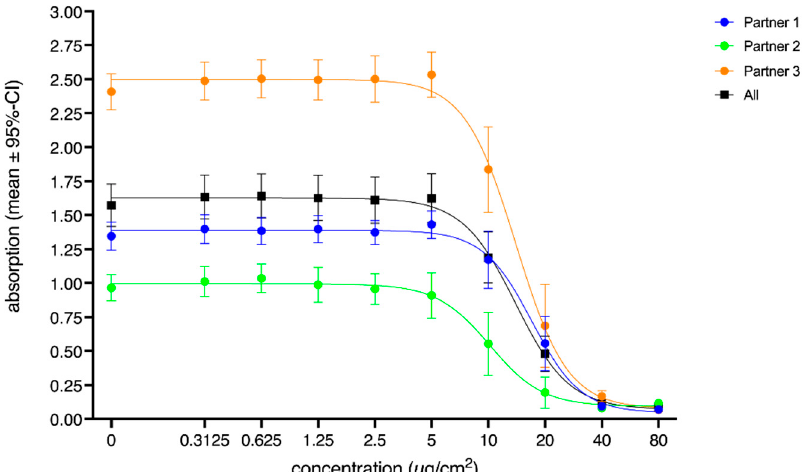
Figure 3. Concentration-dependent effects of the random factor partner on the absorption. Values represent mean values (corrected absorption) of the three partners, as well as the average (black square). Error bars indicate the corresponding 95% confidence intervals. The concentration is the administered concentration of the ENMs based on the initial dispersion.